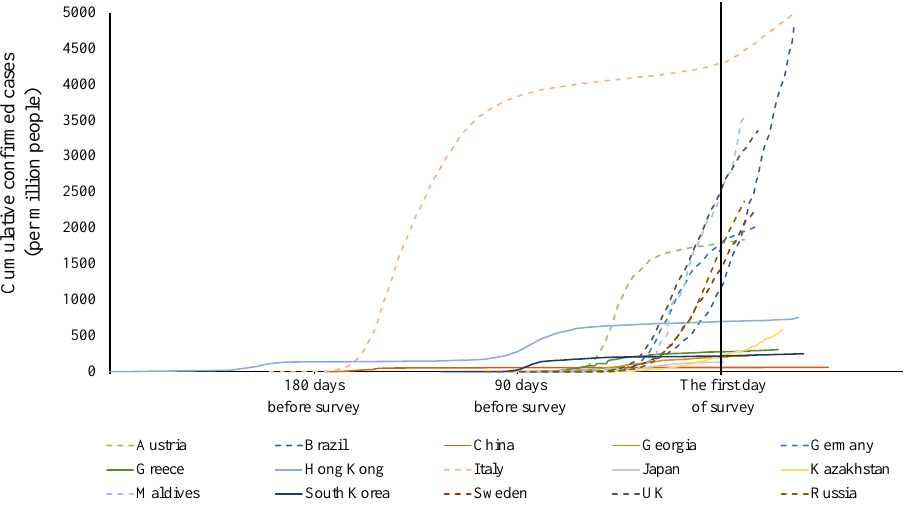
Figure 2. Cumulative confirmed cases (per million people) of studied countries/regions. Figures represent the number of daily cumulative confirmed cases (per million people) from the first re- ported cases to the final day of the VIC survey in each country/region. The solid lines represent countries/regions in the low severity group. The dotted lines represent countries/regions in the high severity group. The reference line is the first day of the VIC survey in each country/region.